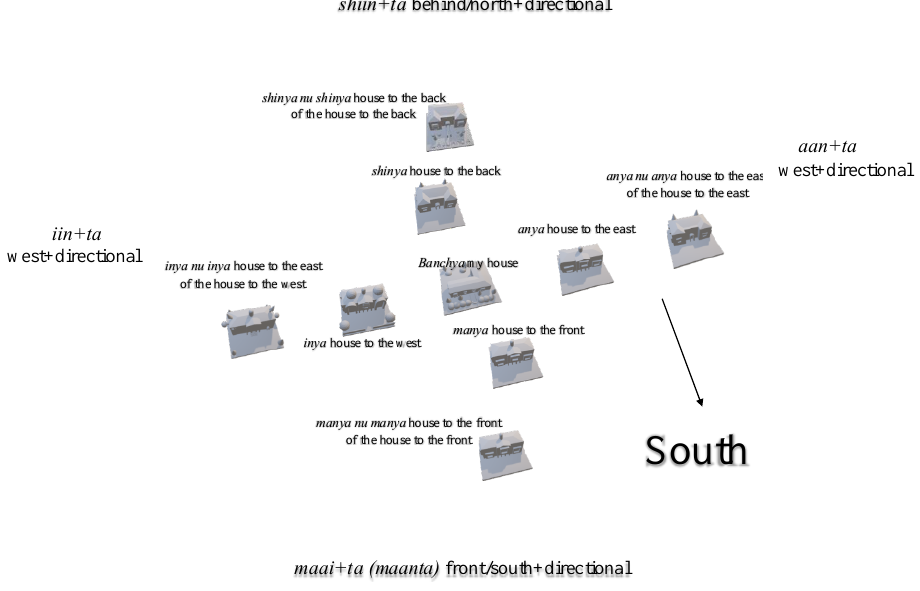
Figure 9. The house system outside of the neighborhood (Shikāza & Aragusuku) .